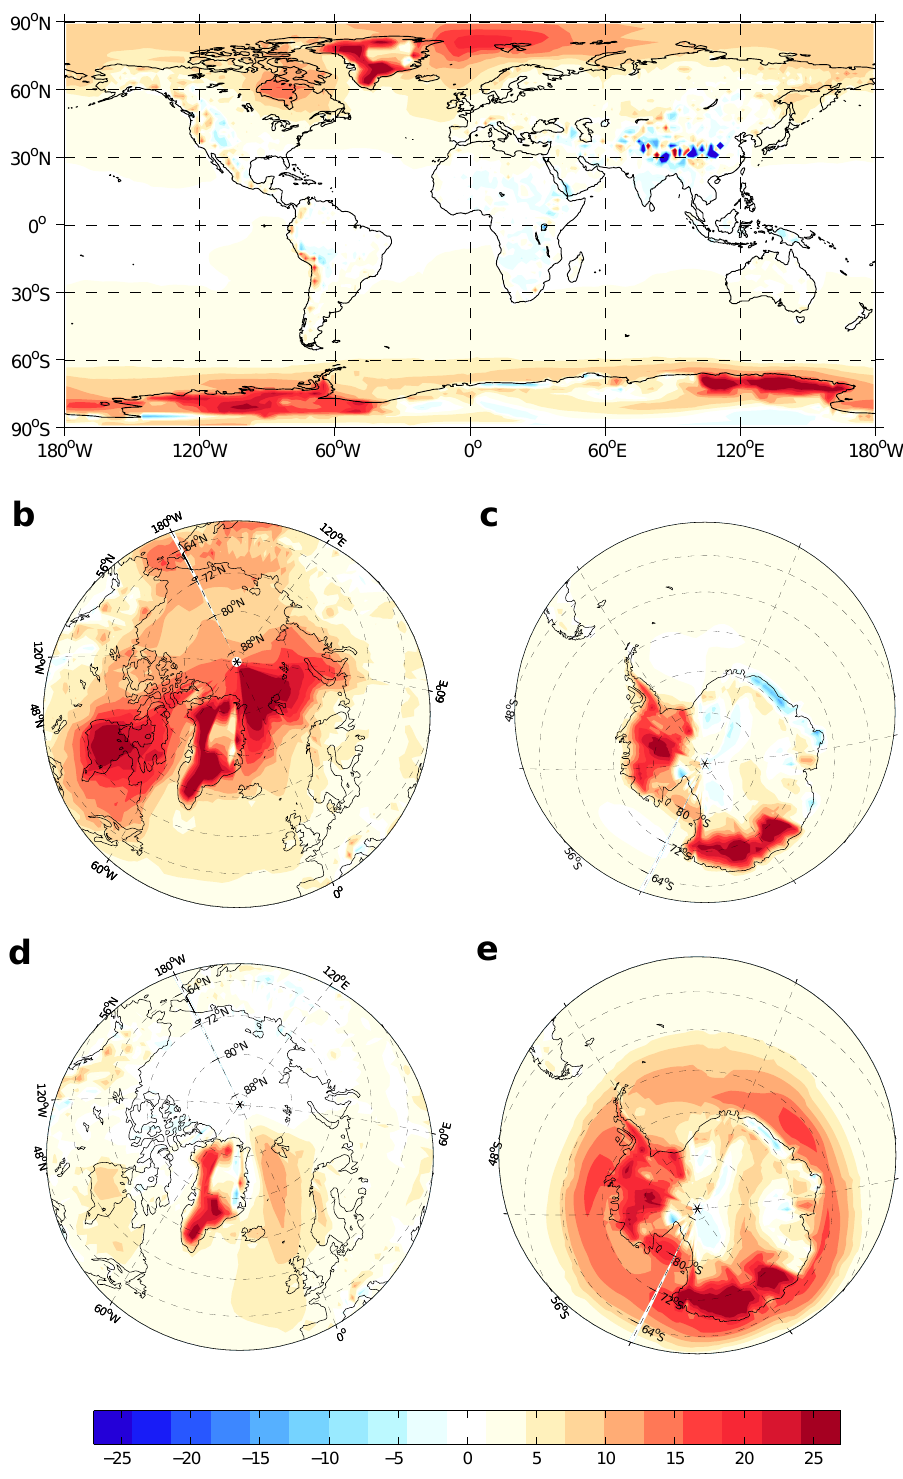
Fig. 8. Pliocene minus pre-industrial differences in model surface air temperatures (2-m, ◦ C). (a) Annual, (b, c) December-January-February, (d, e) June-July-August.